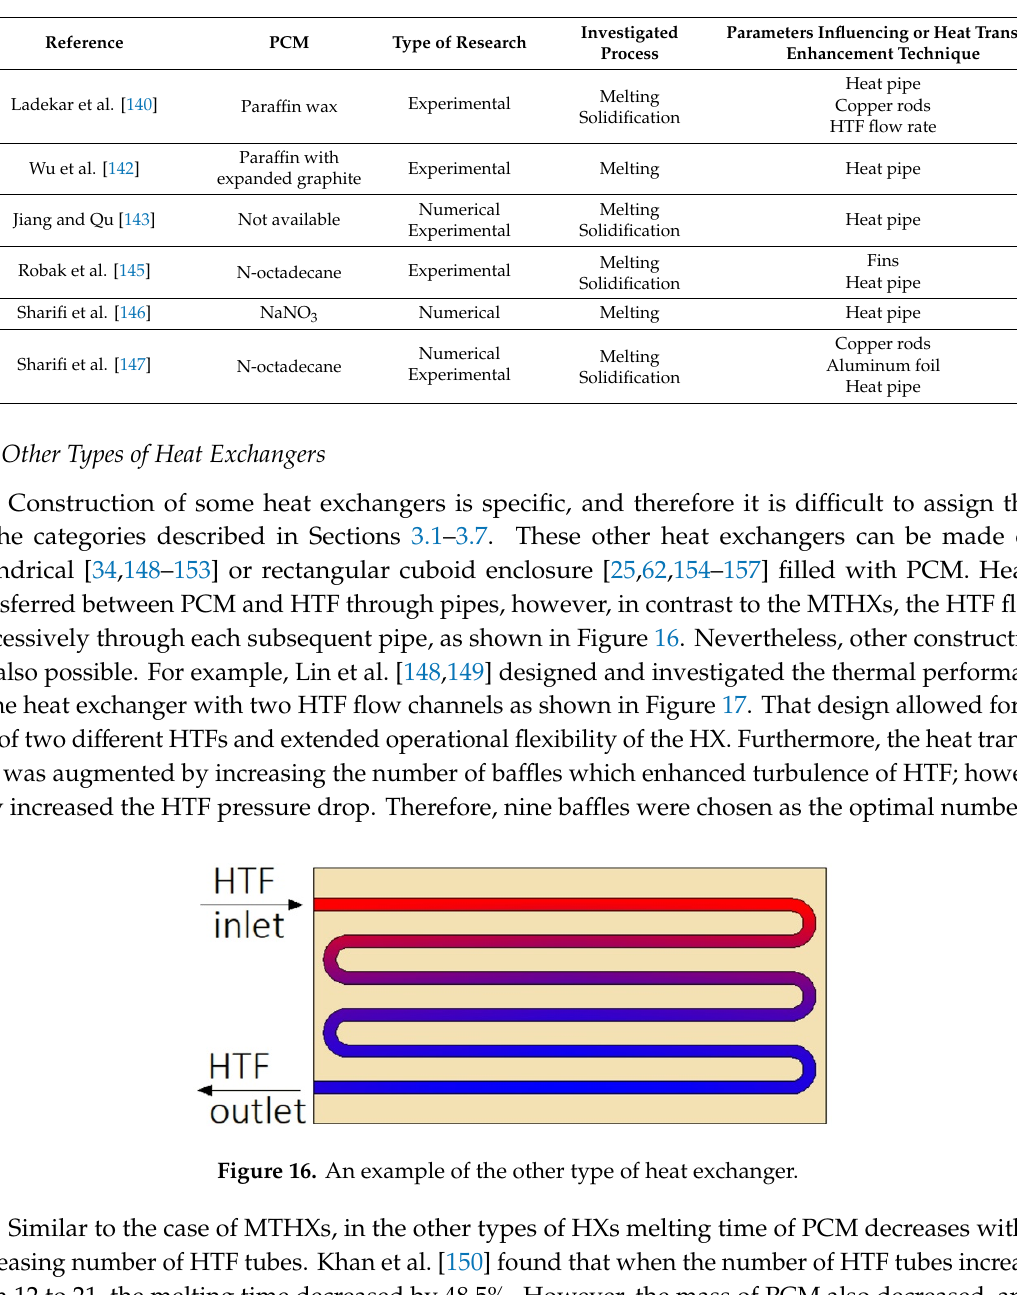
Figure 17. Heat exchanger designed by Lin et al. [148,149]. Similar to the case of MTHXs, in the other types of HXs melting time of PCM decreases with an increasing number of HTF tubes. Khan et al. [150] found that when the number of HTF tubes increased from 12 to 21, the melting time decreased by 48.5%. However, the mass of PCM also decreased, and it could impact the melting time as well. Ebrahimi et al. [151] also investigated the influence of the number of HTF tubes on the phase change time, but the mass of PCM was kept constant. It was reported that when the number of U-pipes increased from 1 to 2 and from 1 to 3, the melting time was reduced by 17% and 24.1%, respectively. Kurnia et al. [46] found that when the number of tubes increased from 2 to 4, the solidification time of the PCM decreased by 50%. The main disadvantage of increasing the number of tubes is a large reduction of the HTF temperature along the flow path, which results in the non-uniform phase change process [154]. Therefore, Besagni and Croci [154] proposed to change the flow path of the HTF from the series configuration to the parallel configuration. In the series configuration, all HTF tubes were connected and increasingly colder HTF flowed into each subsequent tube. In the parallel case, the tubes were connected in such a way that three sections were created and the hot HTF flowed into each section. Nevertheless, it was concluded that both heat exchangers performed similarly. The influence of using fins on the thermal performance of the other types of HXs was investigated by numerous scientists: Talukdar et al. [156], Khan et al. [150], and Pakalka et al. [155]. Talukdar et al. [156] reported that the application of 12 fins reduced the solidification time by about 50%. Khan et al. [150] found that as the length of fins increased three times, the melting time of PCM decreased by 57.32%. Furthermore, when the thickness of the fins was changed from 1 to 5 mm, the melting time decreased by 16.45%. However, such modifications decreased the heat storage capacity of the HX by 1.94% and 5.7%, respectively. Therefore, increasing the length of fins is more effective